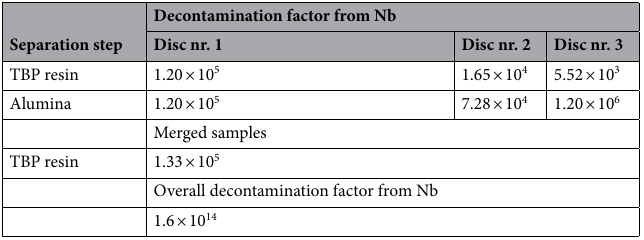
Table 1. Decontamination factors of 93 Mo from Nb for each separation step.